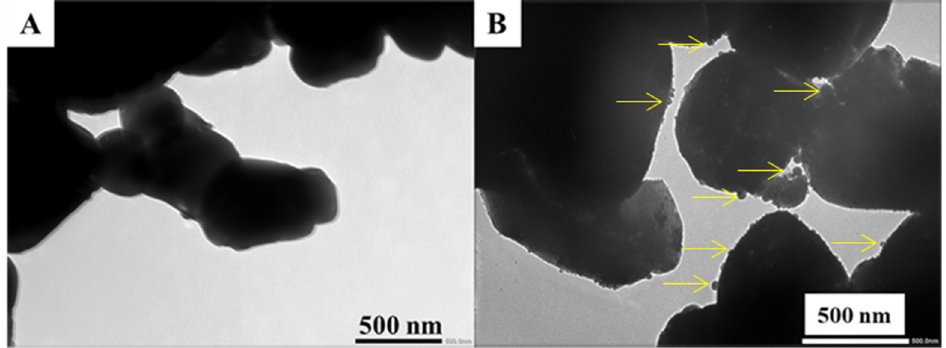
Figure 3. TEM image of the SRT0 ( A ) and SRT1 ( B ) sample.